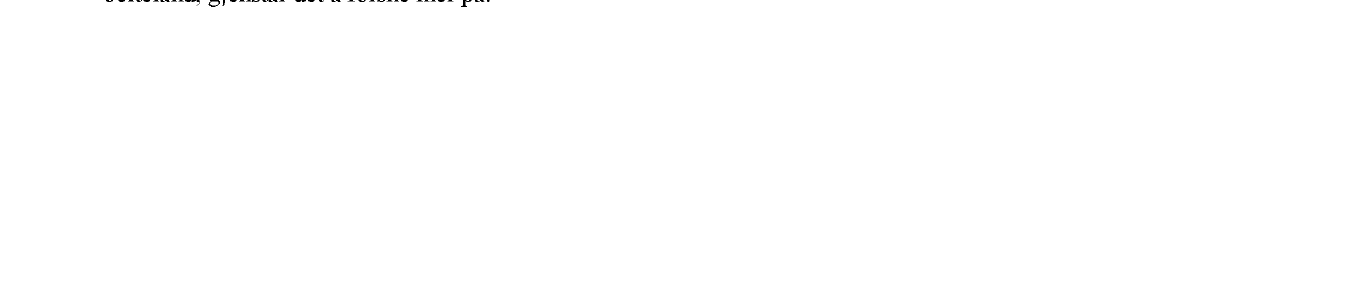
Forskning på effekter av menneskeskapt forstyrrelse av rein gjennom 25 år - eksisterende kunnskap og framtidige utfordringer Kunnskapen om reinens reaksjoner på menneskeskapt forstyrrelse har økt betydelig i løpet av de siste 25 årene som et resultat av forskningen på konsekvenser av den økende utbyggingen av industri, infrastruktur og kraftutbygging i rein- og caribouhabitat. Forskningen på forstyrrelse av Rangifer har i stor grad fulgt to forskjellige retninger, der man har studert enten lokale eller regionale effekter av forstyrrelse. Forskningen på lokale effekter kartlegger den umiddelbare responsen til enkeltdyr i møte med en forstyrrelseskilde, ved å måle f.eks. fysiologiske reaksjoner eller endring i atferd lokalt. Disse studiene har i hovedsak konkludert med at enkeltdyr kan reagere på forstyrrelse ved flukt <1 km, og at de energimessige kostnadene som følge av fysiologiske eller atferdsmessige reaksjoner normalt sett ikke påvirker reinens kondisjon på lang sikt. Forskning på regionale effekter fokuserer på en stor andel av flokken framfor enkeltdyr, og kartlegger eventuell unnvikelse og endringer i beitebruk over en større del av beiteområdet, også flere kilometer unna forstyrrelseskilden. Disse studiene konkluderer i hovedsak med at forstyrrelseseffekter kan være langvarige og føre til betydelig tap av beiter ved at en stor del av flokken unnviker forstyrrelsessoner, og ved at infrastruktur kan oppfattes som delvis ugjennomtrengelige barrierer og dermed avskjære deler av beiteområdet. En stor mengde forstyrrelsesstudier, inkludert flere studier utført før og etter utbygging, har vist at selv om de lokale effektene kan være små, kan veier, rørledninger, demninger og turistanlegg føre til en 40-95% reduksjon i bruk av områder innen 2,5-10 km fra forstyrrelseskilden. Lokale og regionale effekter opererer på forskjellig skala både i tid, rom og i forhold til antall dyr studert, noe som gir to verdifulle og komplementære sett med kunnskap om forstyrrelse av rein. Den tredje typen effekt som ofte blir nevnt; kumulative effekter på produksjon i flokken som et resultat av tap av beiteland, gjenstår det å forske mer